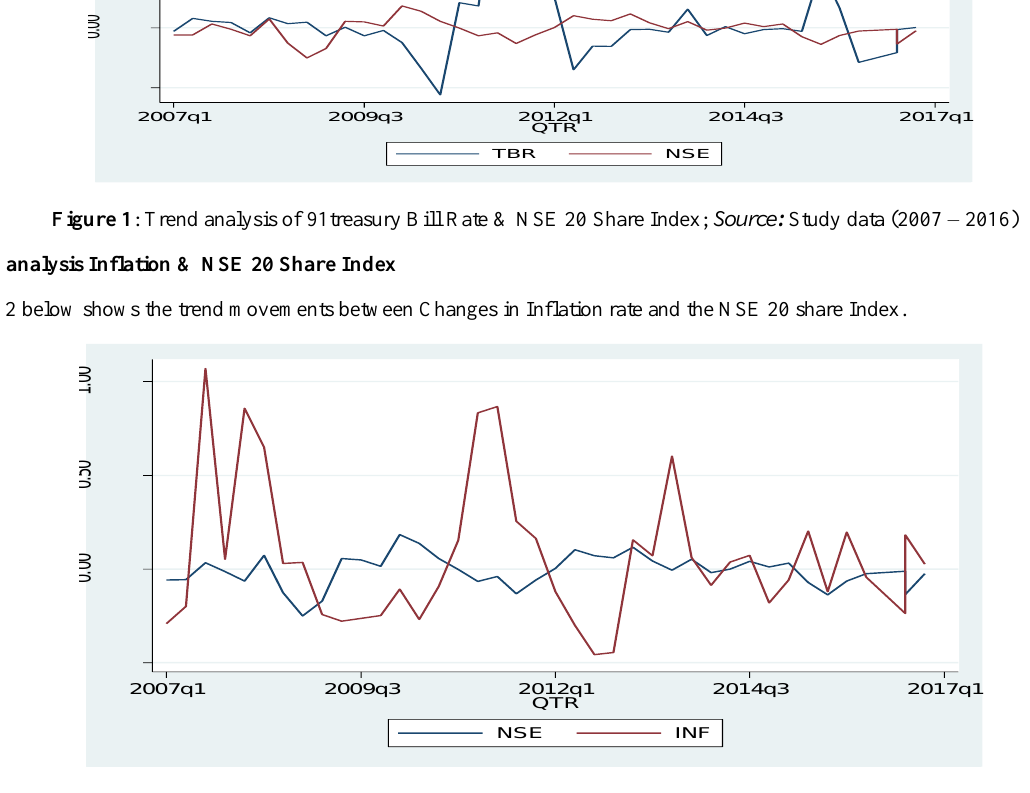
Figure 2: Trend movements between changes in inflation rate and the NSE 20 share Index Source: Study data (2007 – 2016) Lagrange-Multiplier Results Table 1: Lagrange-Multiplier